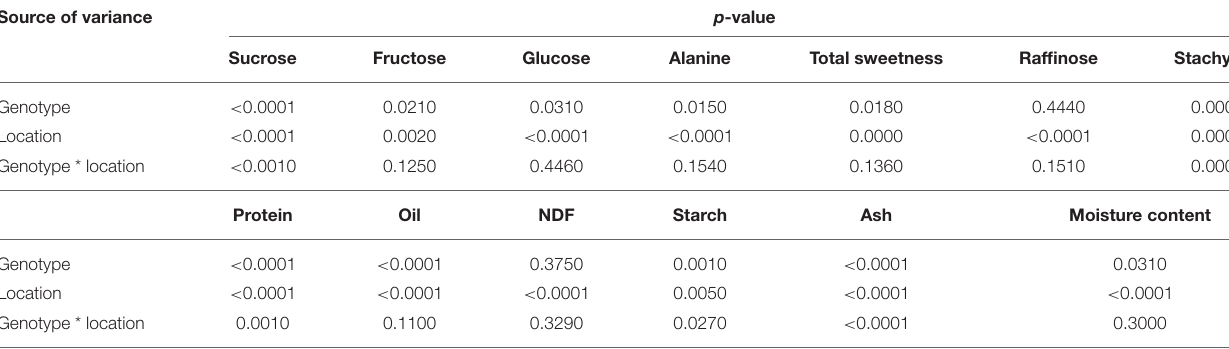
TABLE 1 | p -values of the two-way ANOVA for all compositions. Source of